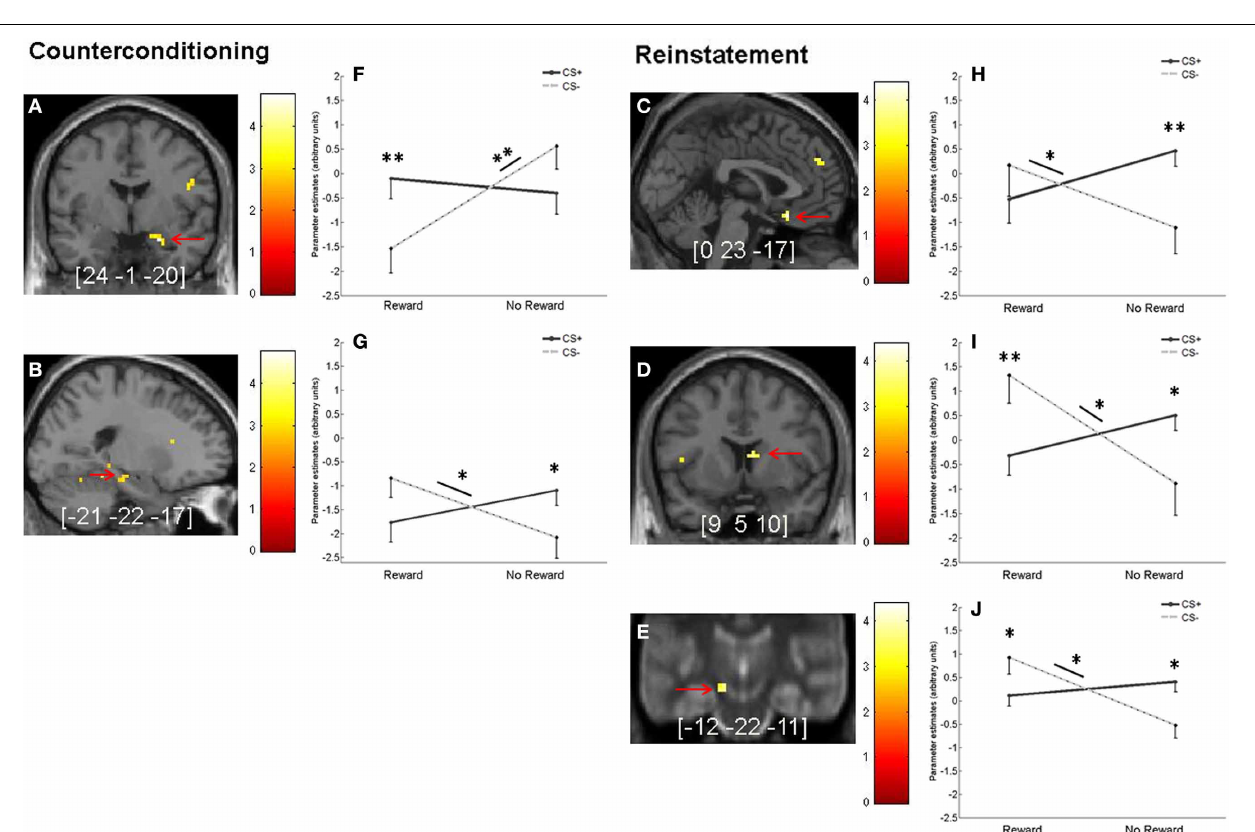
rewarded vs. unrewarded cues in left ventral striatum. Images are shown in neurological orientation at p < 0 . 005 (uncorrected), for visualization purposes. Color bars indicate T -values. Peak coordinates are given in MNI space.